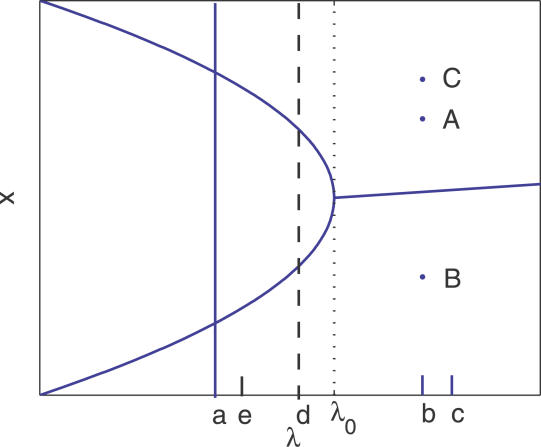
A Schematic Bifurcation Diagram with a Normal (Supercritical) Hopf Bifurcation for Illustrating the Transient Resetting Mechanism